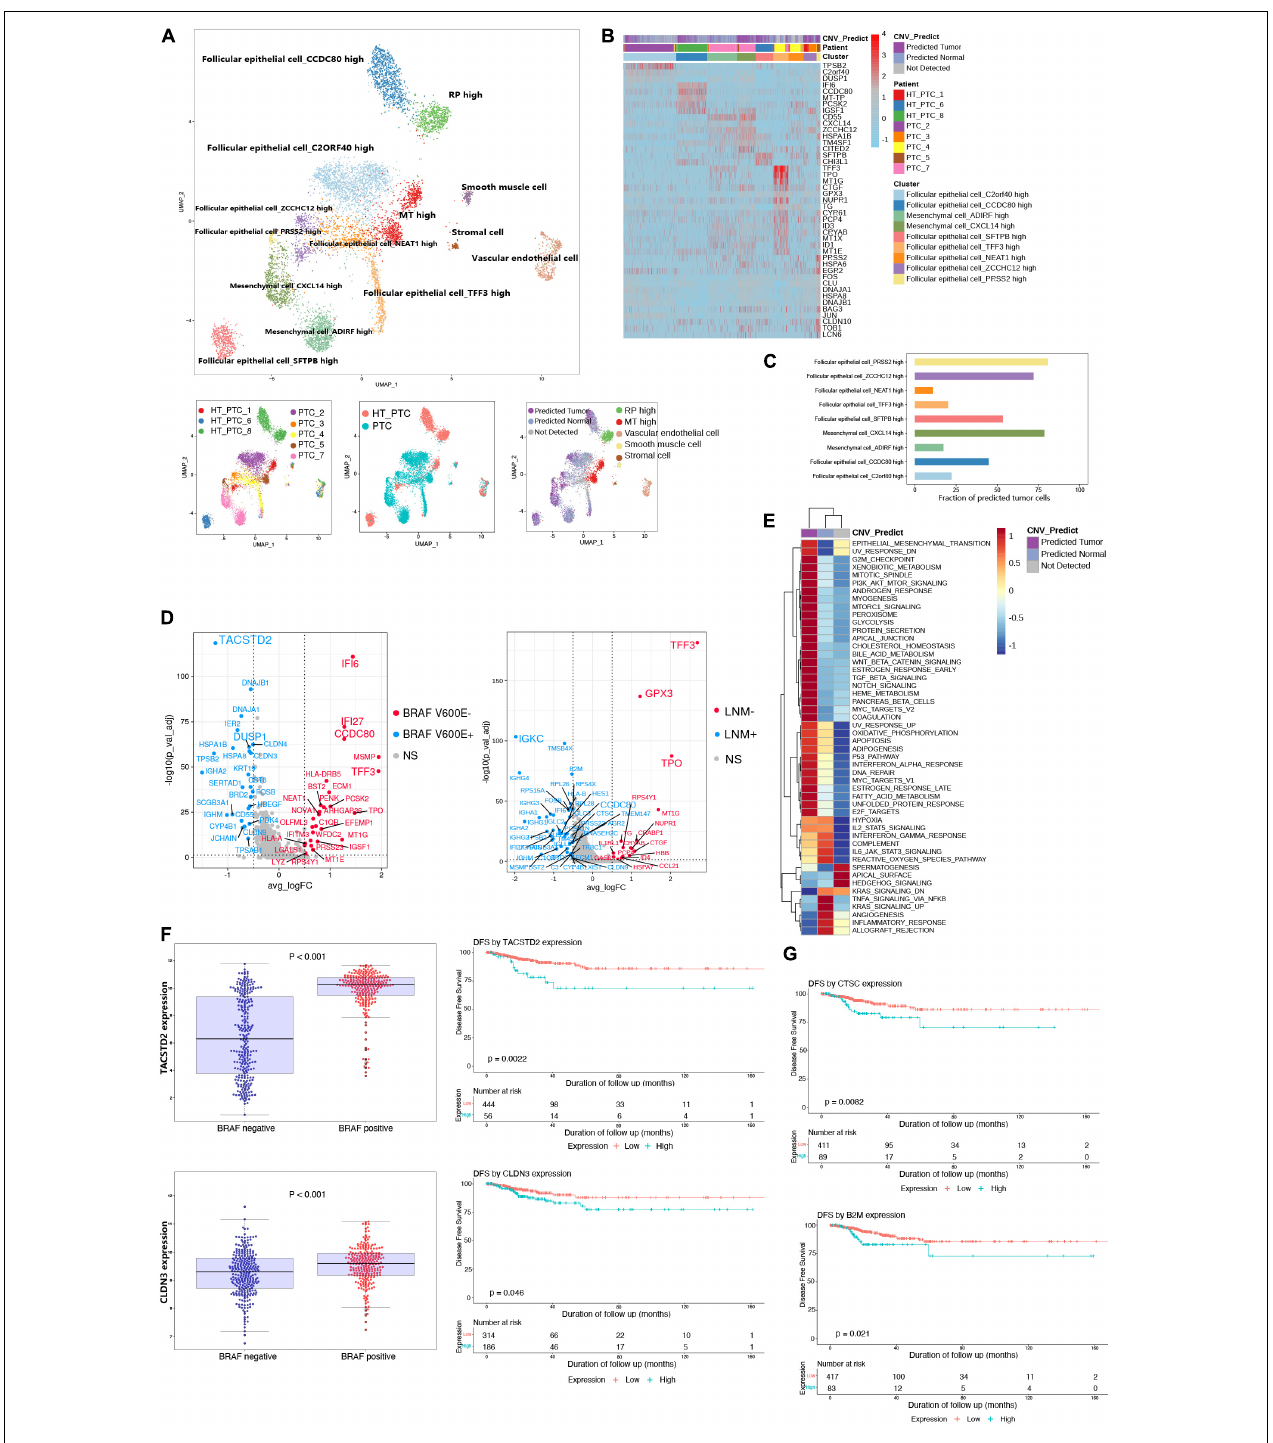
FIGURE 2 | Reclustering of parenchymal cells and identification of malignant cells. (A) UMAP plot of parenchymal cell subclusters colored by cell types, patients, PTC types, and CNV prediction. (B) Heatmap shows the DEGs of clusters, patients, and CNV groups. PTC, samples from PTC patients without concurrent HT; HT_PTC, samples from PTC patients with concurrent HT. (C) Fractions of predicted tumor cells in each cell subcluster. (D) Volcano plots show DEGs of follicular epithelial cells based on BRAF V600E mutation and LNM. BRAF V600E + , highly expressed genes in patients with BRAF V600E mutation; BRAF V600E - , highly expressed genes in patients without BRAF V600E mutation; LNM + , highly expressed genes in patients with LNM; LNM-, highly expressed genes in patients without LNM; NS, genes with no significant expression patterns. (E) GSVA pathway enrichment of different group based on CNV level. (F) Expression level of TACSTD2 and CLDN3 between different mutation groups and DFS analysis in the TCGA-THCA cohort. (G) DFS analysis of CTSC and B2M in the TCGA-THCA cohort.